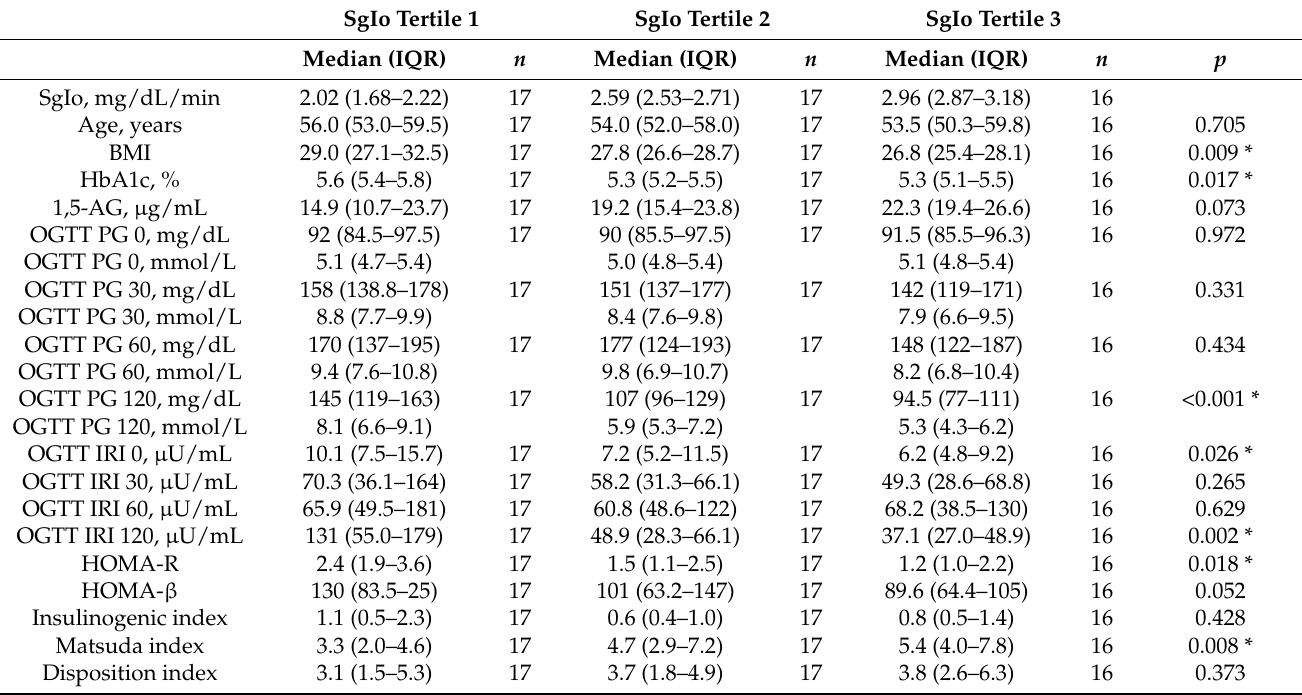
Table 1. Characteristics of the participants according to SgIo tertile